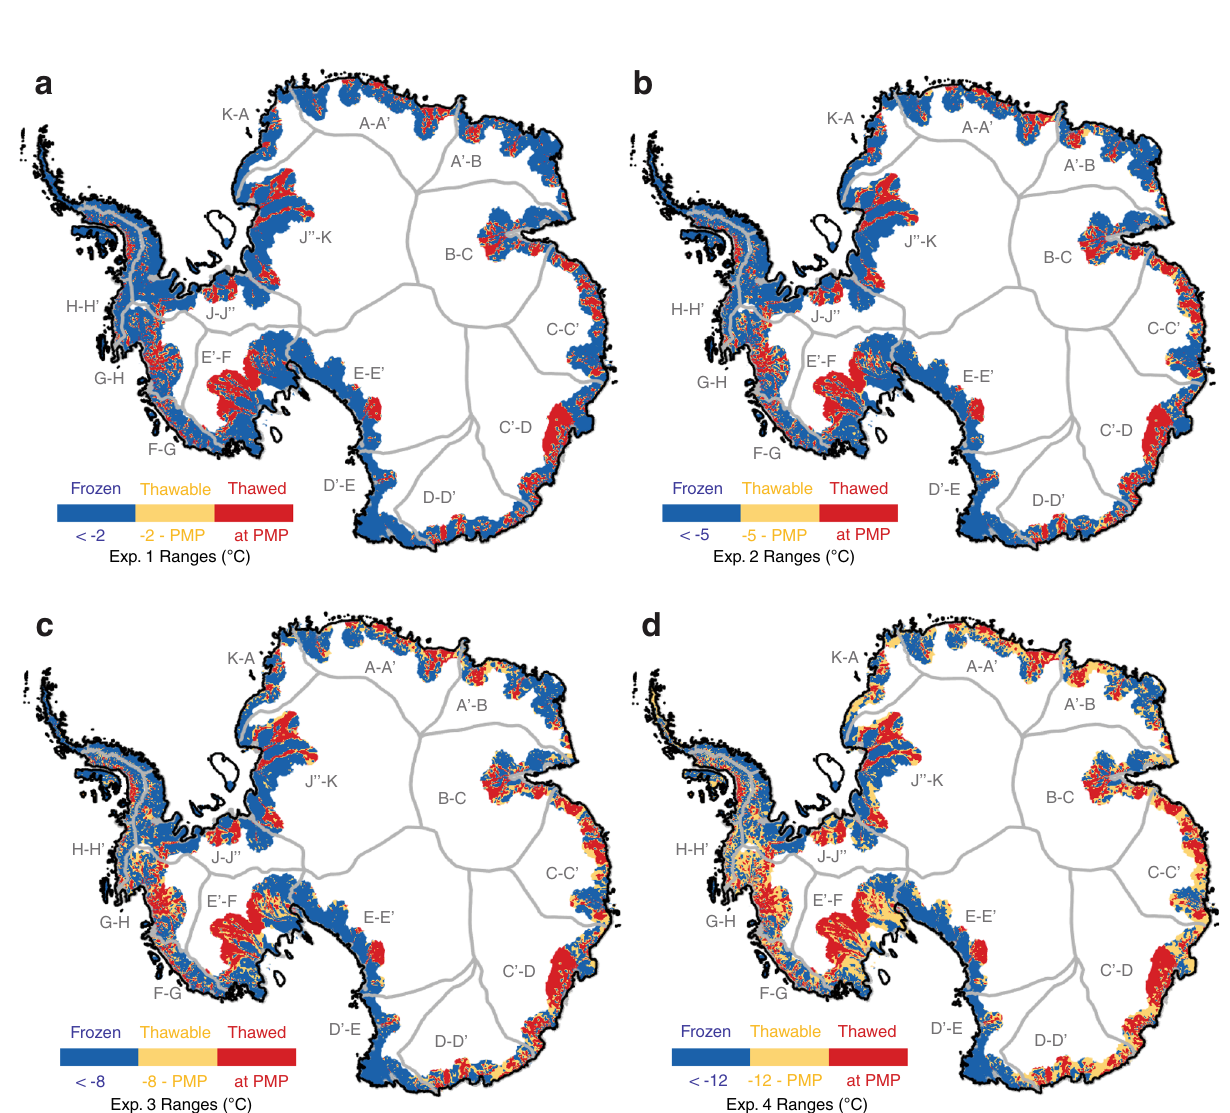
Fig. 2 | Basal temperature ranges used to con fi gure the thaw experiments. a Map ofexperiment zone (colored peripheryregion) divided into frozen, thawed, and thawablebedregimesfor Exp.1. The frozen,thawable,and thawed bed ranges comefromourISSMderivedbasaltemperatures.Theexperimentzoneisde fi nedas